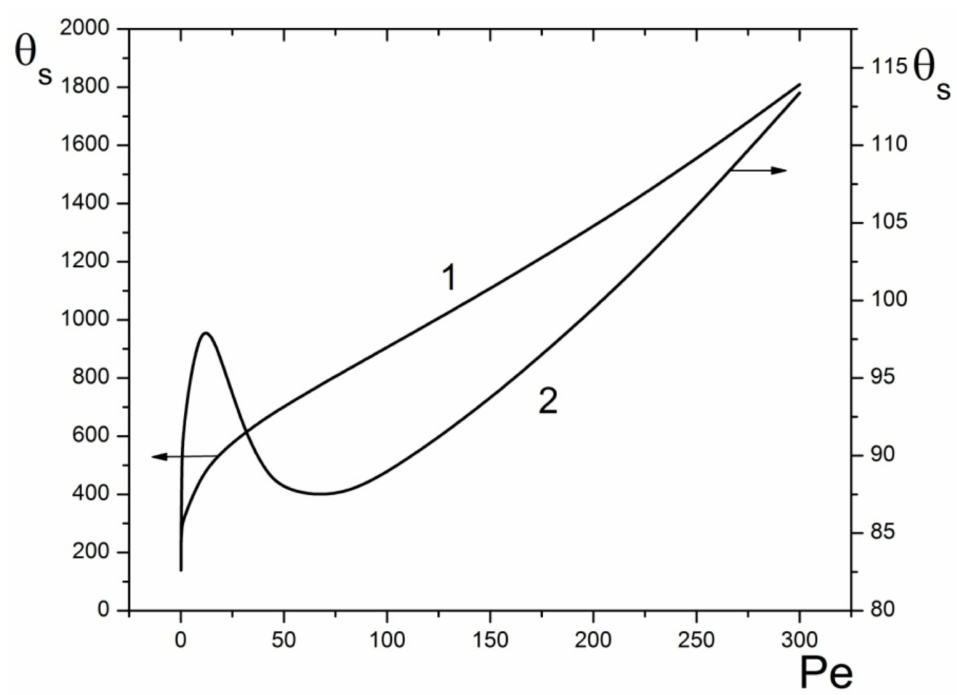
Figure 6. Transition from monotonic to non-monotonic critical curve. Approximate model (29). A = 2.75 × 10 − 18 ; h s = 7.14 × 10 2 ; µ = 75.0; g = 1.22 × 10 − 20 , 1—Ar = 0.02, 2—Ar =